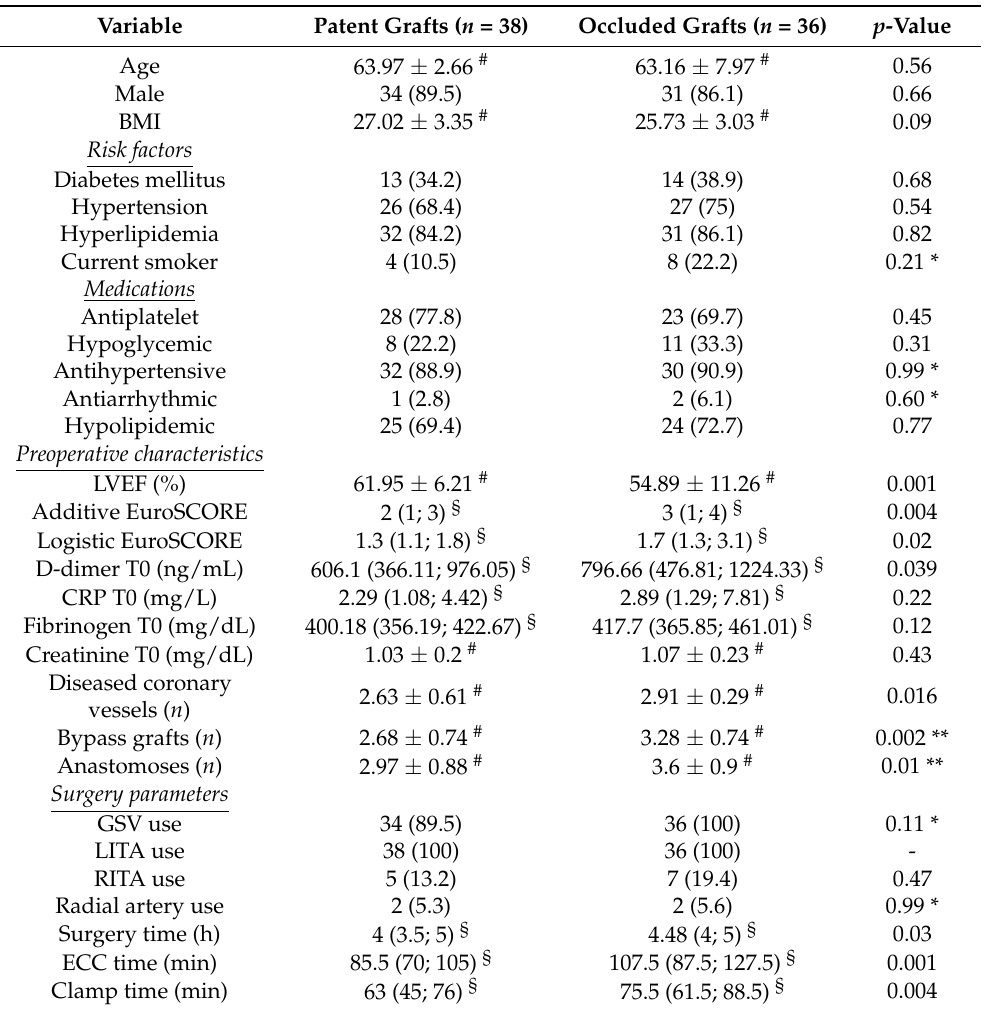
Table 1. Clinical characteristics of the study